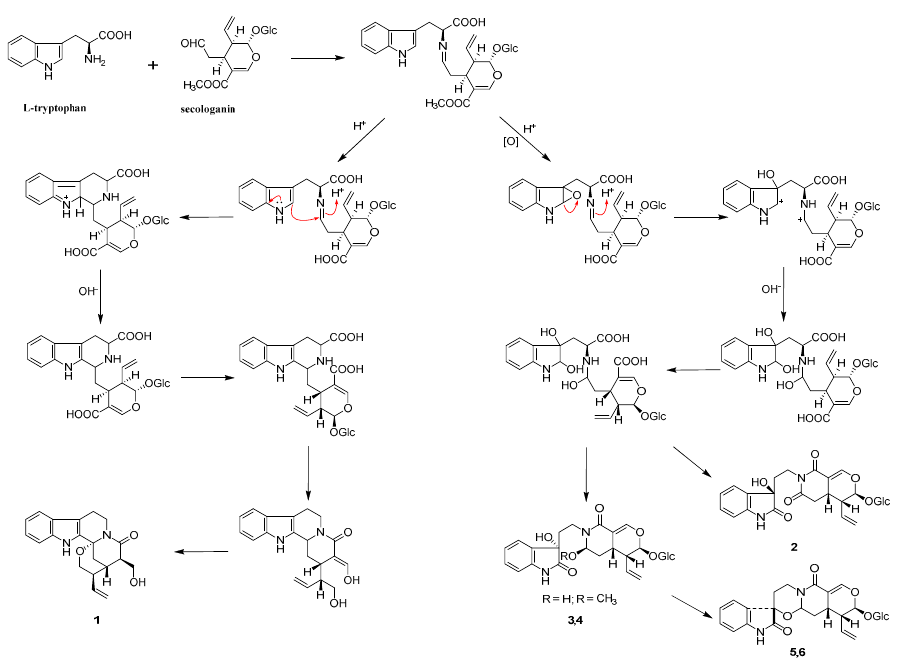
Scheme 1. The plausible biosynthetic pathway for 1 – 6 .